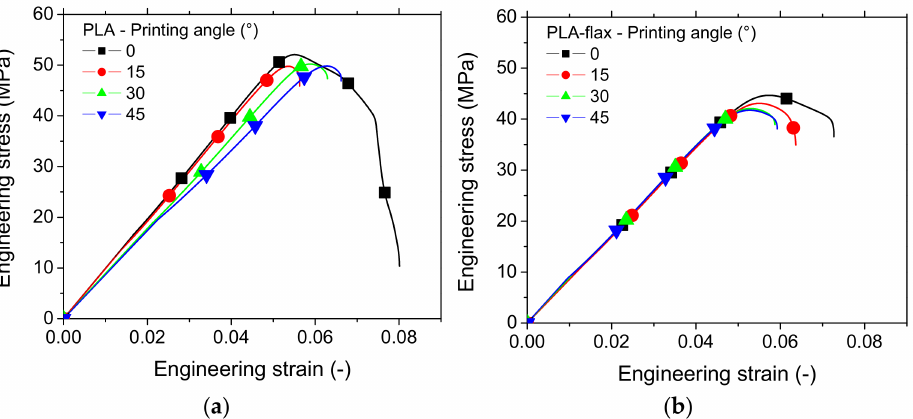
Figure 3. Comparison between the tensile performance of PLA and PLA-flax samples printed with the following conditions: T P = 200 ◦ C, T B = 60 ◦ C at various printing angles: ( a ) PLA; ( b )